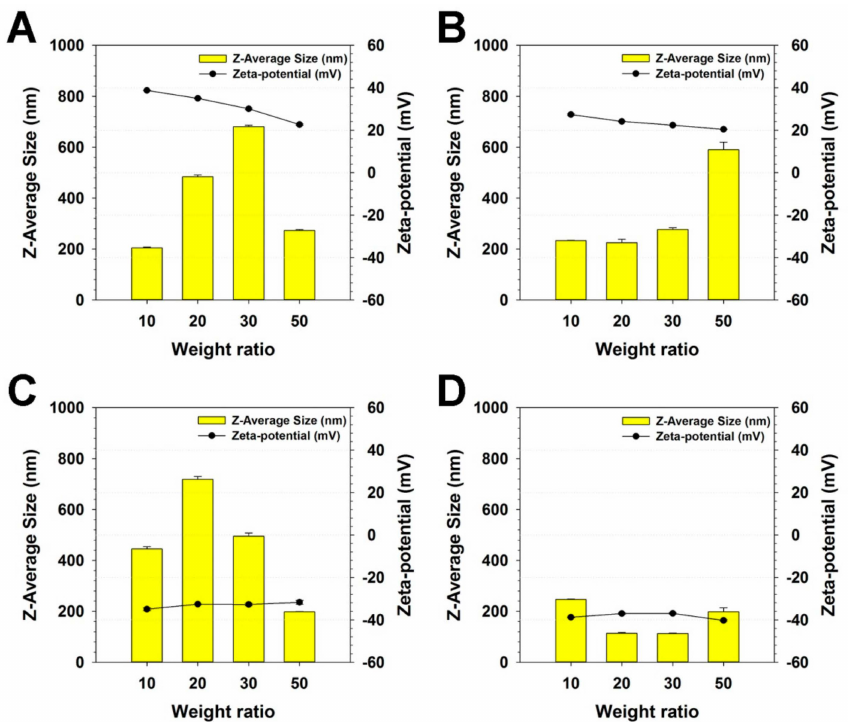
Figure 1. Z-Average sizes and zeta-potential values of ( A ) PK 5 E 5 (PEI-rGO), ( B ) PK 5 E 7 (PEI-rGO), ( C ) PK 5 E 9 (PEI-rGO), and ( D ) PK 5 E 13 (PEI-rGO) with various weight ratios (PKE:PEI-rGO). Data are shown as the mean ± S.D ( n =